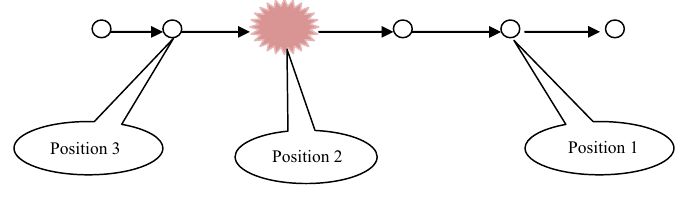
Figure 3. Supply chain